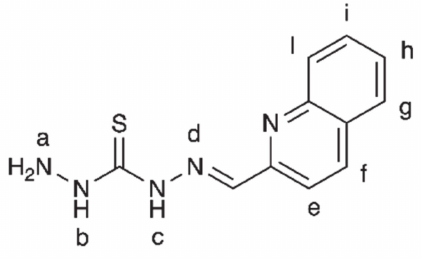
Figure 6. Quinoline-2-carboxaldehydemonothiocarbohydrazone